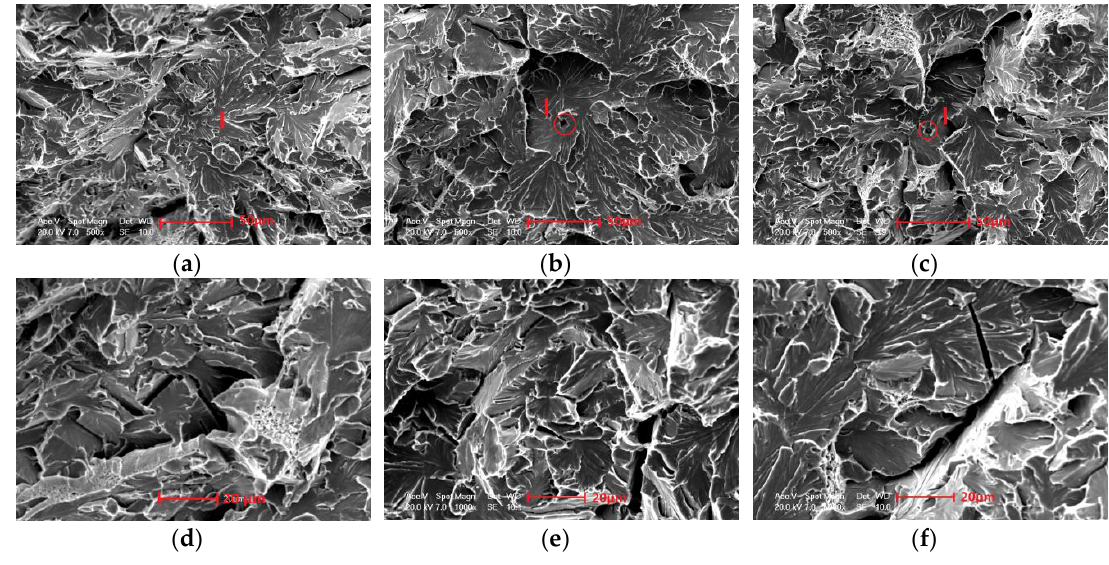
Figure 9. SEM fractography of impact specimens. ( a , d ) 0 t; ( b , e ) 1/4 t; ( c , f ) 1/2 t. Cleavage initiation sites are denoted as I; inclusions are denoted by red circles.